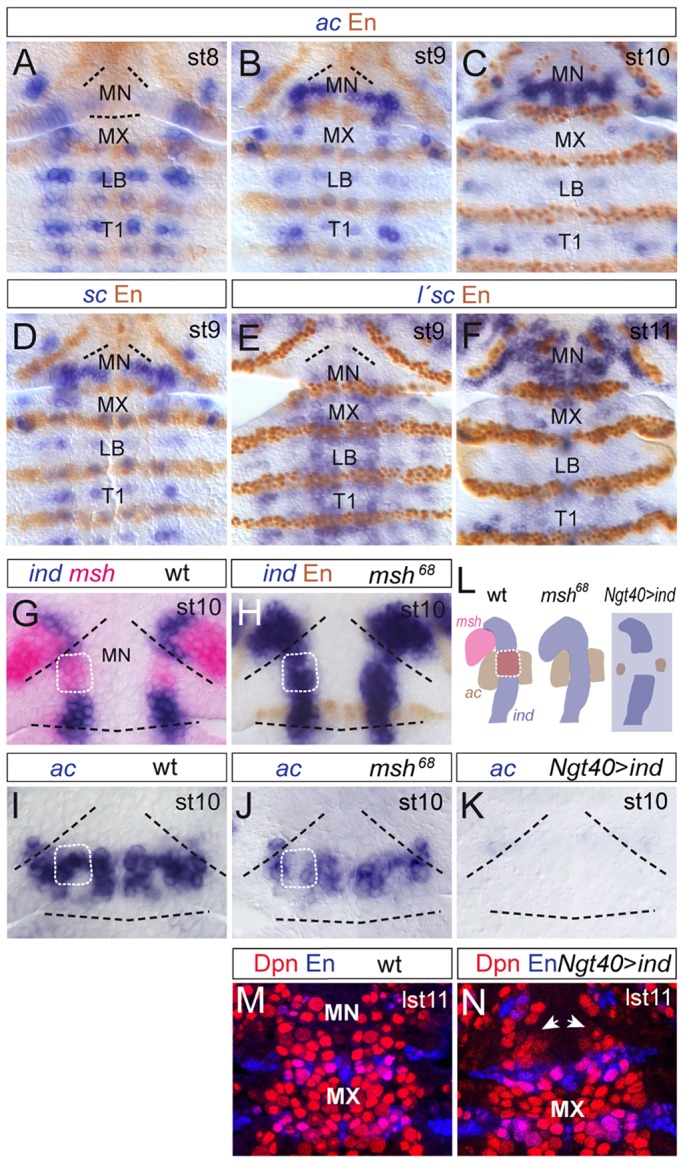
Proneural gene expression in gnathal segments and its segment-specific modification by the activity of DV genes (ind, msh). (A) Stage 8, showing delayed onset of ac expression in MN. (B,C) During stage 9/10 ac is expressed in a large domain in MN. (D) Expression of sc is similar to that of ac. (E,F) At stage 11 l'sc expression is downregulated in MX and LB, but is prominent in anterior MN. Black lines (A,B,D,E) indicate the segmental border of MN. (G-L) Stage 10. Black dashed lines indicate segmental borders and white dotted frames indicate corresponding regions of intermediate neuroectoderm. Ectopic ind expression in intermediate mandibular neuroectoderm in msh68 (H) or Ngt40>ind (K) embryos represses ac (J,K). (L) Summary of G-K (see main text for details). (M,N) Composite confocal images of Dpn and En labeling in wild-type (M) and Ngt40>ind (N) embryos at late stage 11. Upon ind overexpression many row 3, 4, 5 NBs and MP2s (arrows), which would normally develop from the mandibular ac expression domain (see Fig. S2.6A′,B′), are lacking.